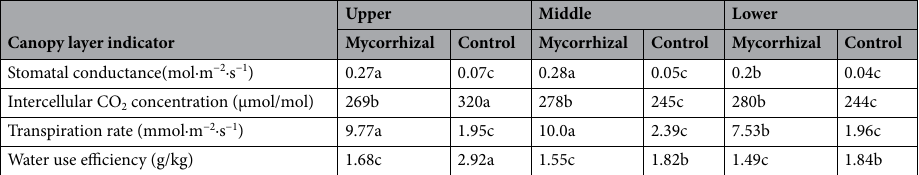
Table 3. Other peanut photosynthetic indicators under the different treatments for 45 days. Within each row, mean values not followed by the same letter are significantly different by LSD ( p < 0.05).